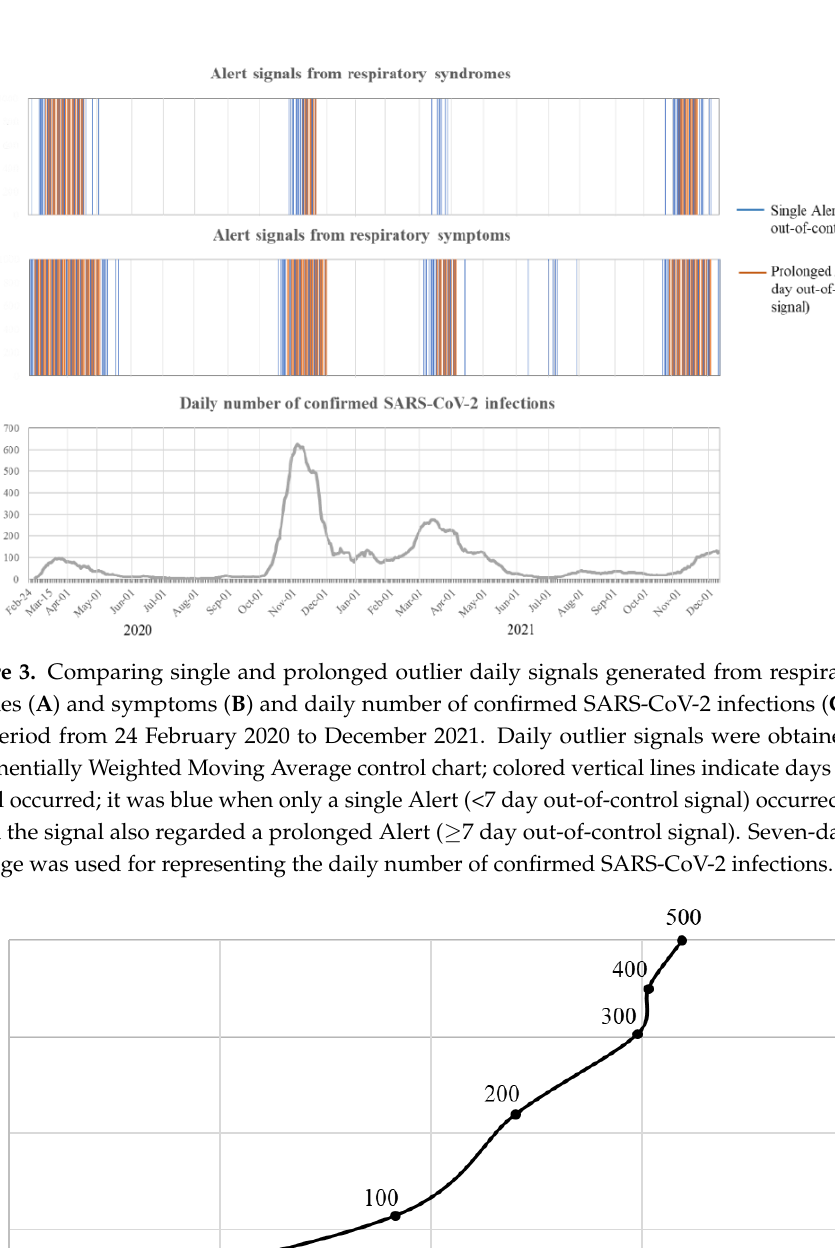
Figure 4. A plot of sensitivity against 1-specificity of the EWMA control chart of respiratory syn- dromes and symptoms for detecting the outbreak onset by varying the threshold of the true outbreak. Thresholds for the number of positive COVID-19 cases, above which the transmission of SARS-CoV-2 became alarming, are reported in the figure for each combination of sensitivity and